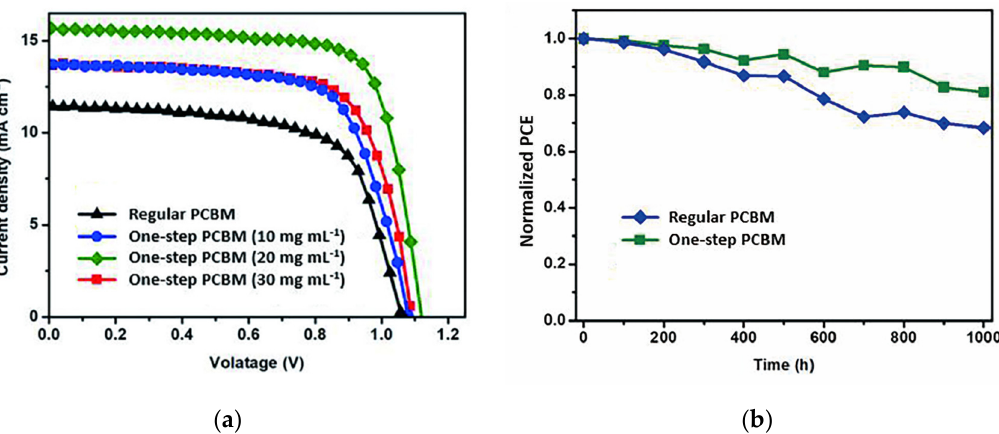
Figure 5. ( a ) J-V characteristics of 2D devices based on ETLs deposited under different parameters. ( b ) Long-term stability test for perovskite devices based on different PCBM deposition methods for 1000 h under illumination at around 25 °C without encapsulation (about 30% humidity).